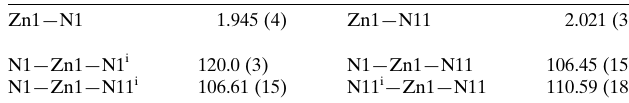
Table 1 Selected geometric parameters (A˚ , (cid:5) ) for 1 .